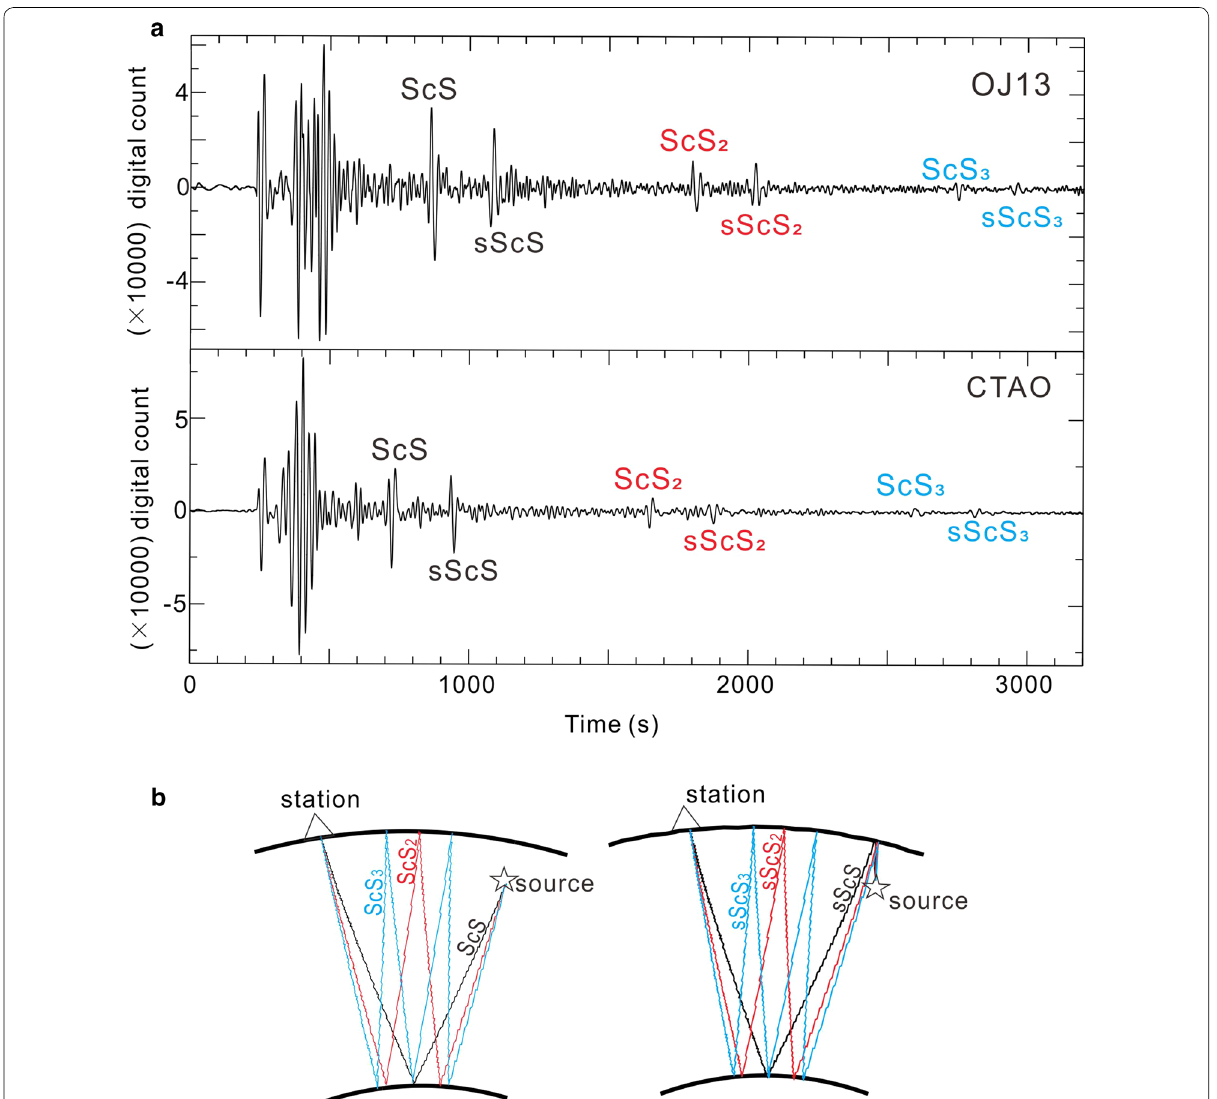
Fig. 2 a Transverse component seismograms for the 2016 event at OJ13 (top) and CTAO (bottom). b Schematic diagrams of multiple ScS ray